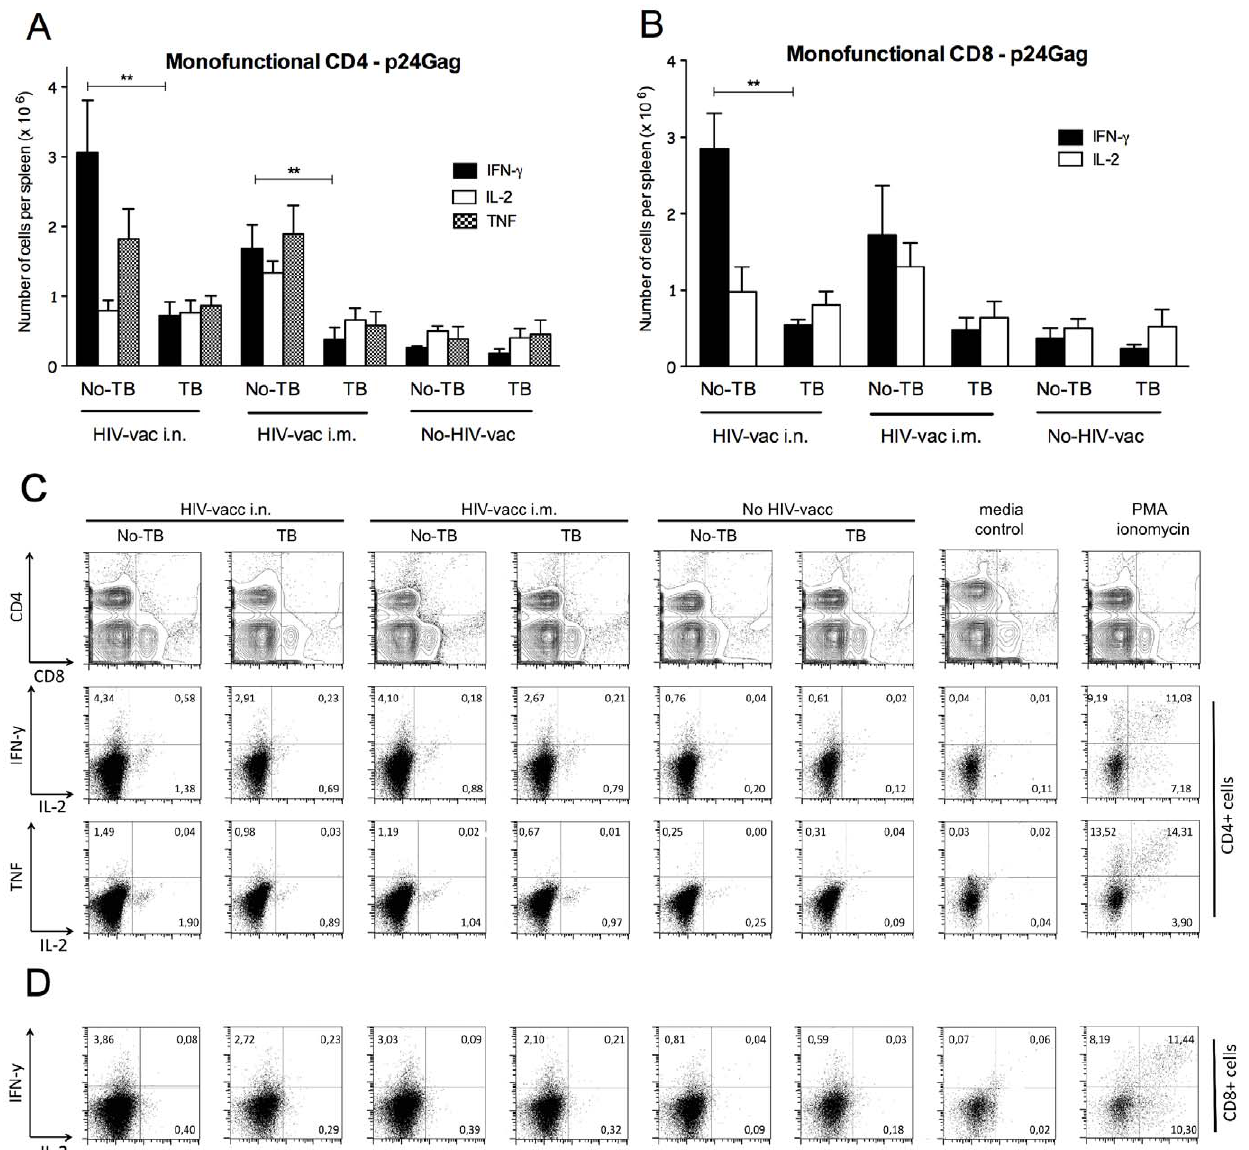
Figure 5. HIV p24Gag-specific T cell cytokine responses in spleens of uninfected or Mtb -infected mice vaccinated with MultiHIV DNA/protein. Splenocytes from Mtb -infected or uninfected mice, which were immunized and boosted with MultiHIV DNA/protein, were isolated 4 wk post-vaccination, restimulated ex vivo with p24Gag antigen, and stained for CD4 and CD8 markers and for intracellular IFN- c , TNF, and IL-2 (details in Materials and Methods). Numbers of p24Gag-specific CD4 + (A) and CD8 + (B) T cells producing one of three cytokines were determined by flow cytometry. Mean number of single cytokine-producing T cells 6 SEM are shown (6–8 animals/group from one individual experiment; **: P , 0.01). Flow cytometry plots depict representative intracellular cytokine staining of CD4 + (C) and CD8 + (D) T cells. The cytokine profile of p24Gag-specific T cells was determined in two separate experiments.